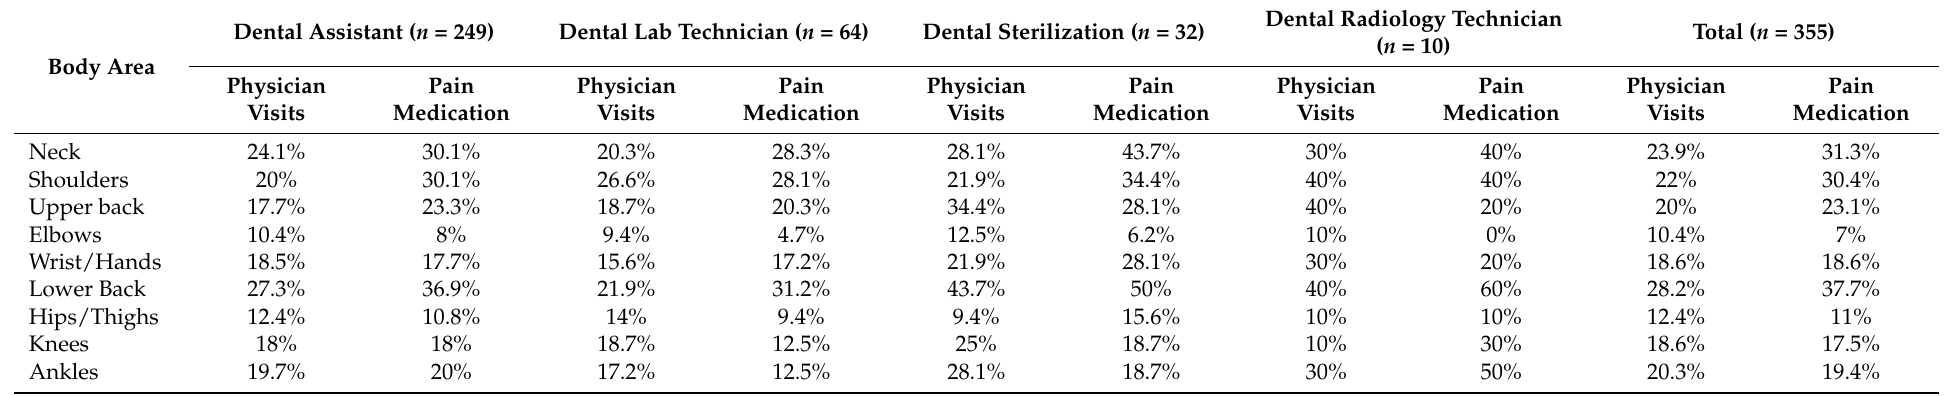
Table 4. Prevalence of Physician visits and pain medication taken for different body areas in the past 12 months for each ADP occupation ( n =